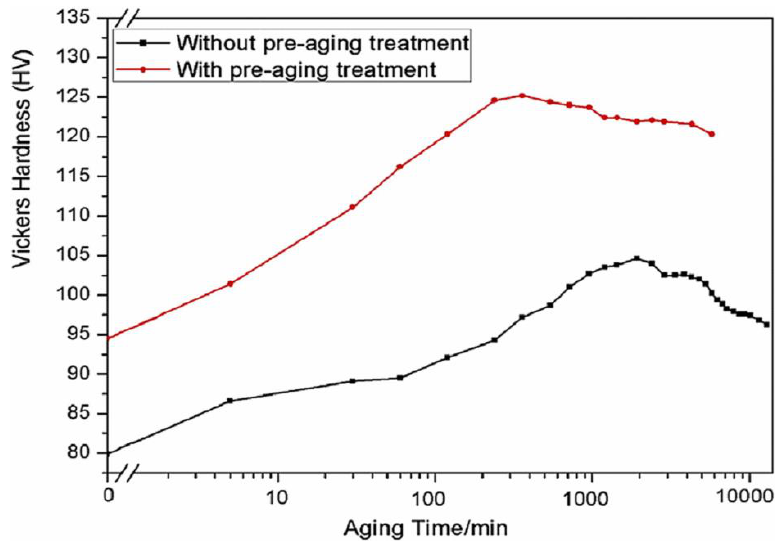
Figure 7. Age-hardening response of Al-5.2Mg-2.0Zn-0.45Cu during aging at 180 °C with or without pre-aging treatment [8].